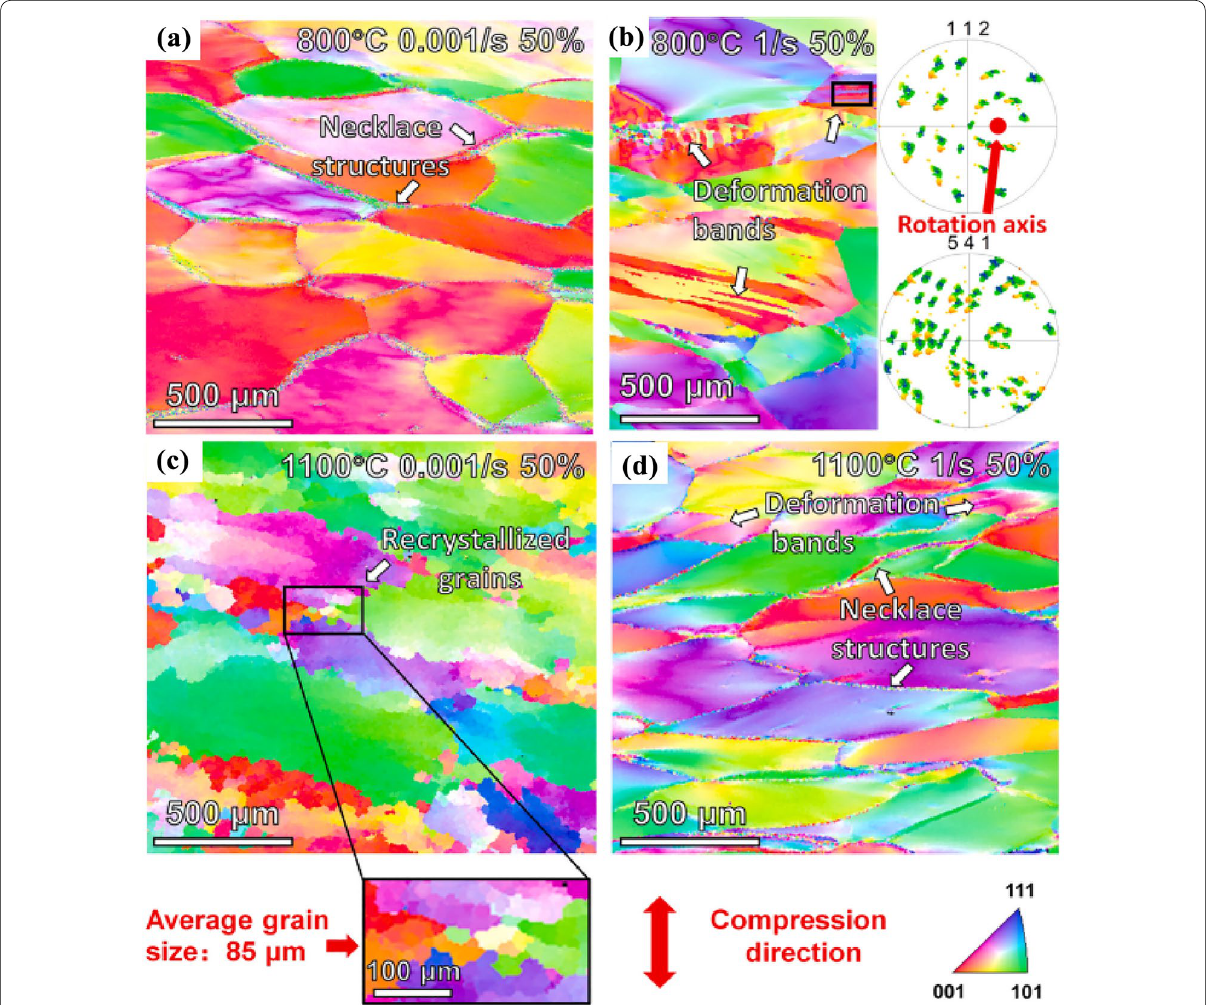
Figure 20 Microstructure evolution of Ti 29 Zr 24 Nb 23 Hf 24 alloy with ~50% strain at [91] ( a ) 800 ℃ and 10 − 3 s − 1 , ( b ) 800 ℃ and 1 s − 1 , ( c ) 1100 ℃ and 10 − 3 s − 1 , ( d ) 1100 °C and 1 s −